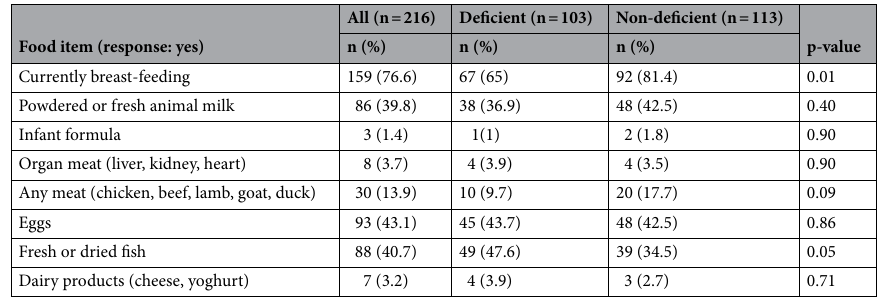
Table 2. Consumption of vitamin D-rich foods in the last 24 h by vitamin D status among 12–24-month-old Bangladeshi children.